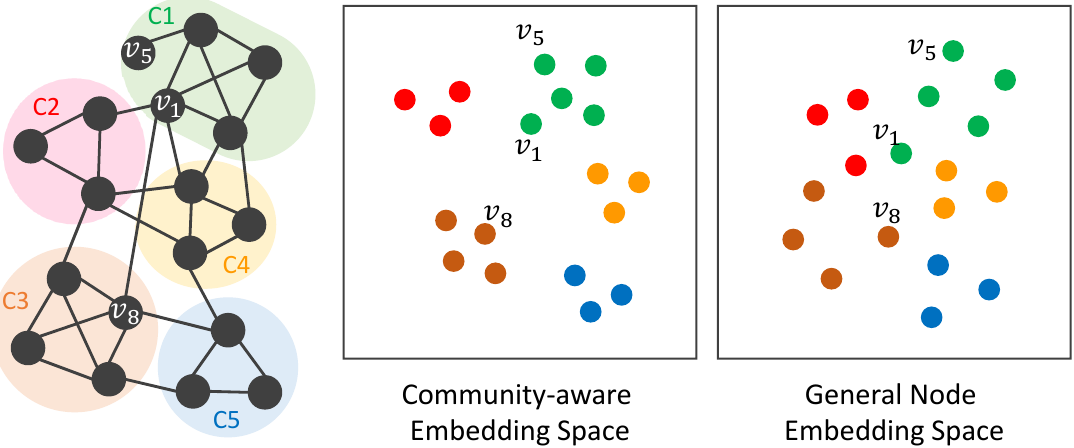
Figure 1. Given a collaboration network in the left, we illustrate and compare community-aware embedding space with general node embedding space, and expect that the community-aware version can better encode the structure of nodes in the embedding